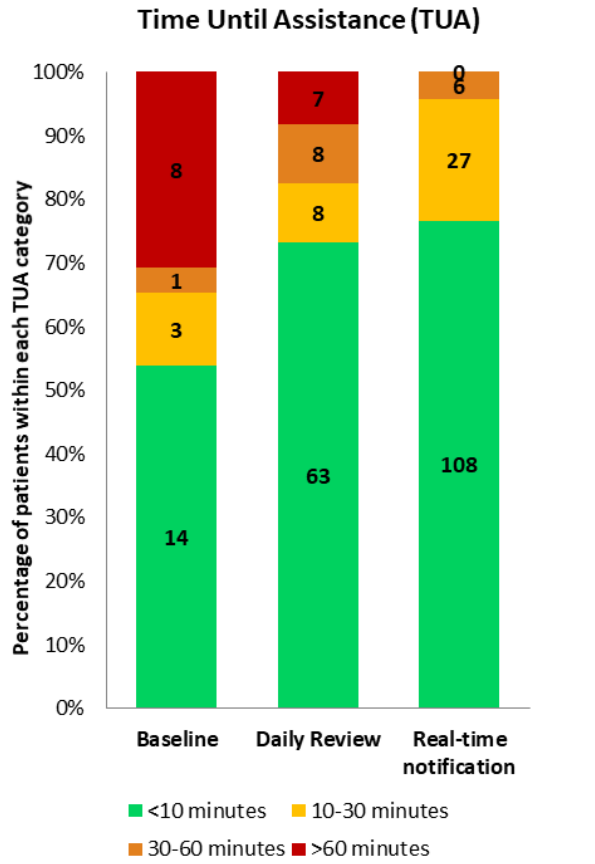
Figure 4. Proportion of falls with short, medium, and long (A) Time Until staff Assistance arrives (TUA) and (B) Time On the Ground (TOG) measures during the 3 time